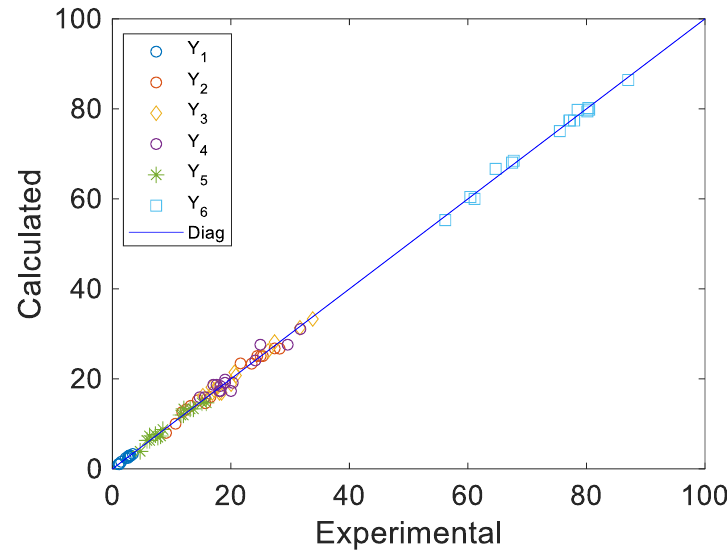
Figure 13. Parity diagram.